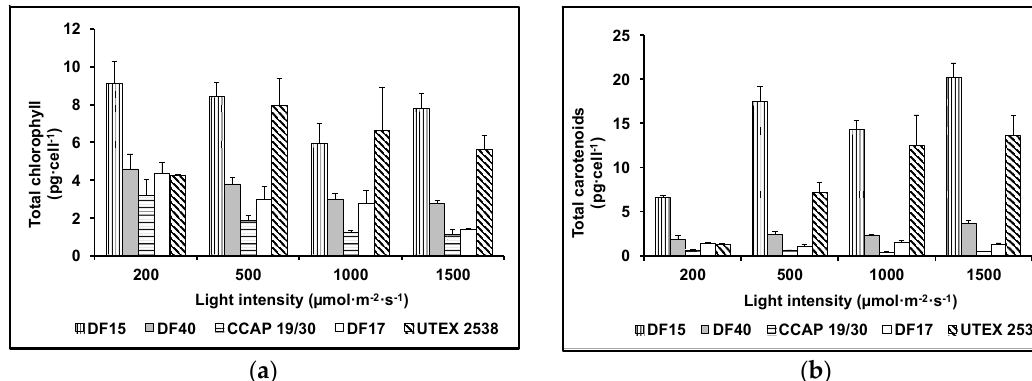
Figure 4. Cellular content of total chlorophyll ( a ) and total carotenoids ( b ) of the five Dunaliella strains grown under four light intensities of 200, 500, 1000, and 1500 µmol·m − 2 ·s − 1 . Samples were taken at the mid log phase and all culture conditions were repeated at least in triplicates.